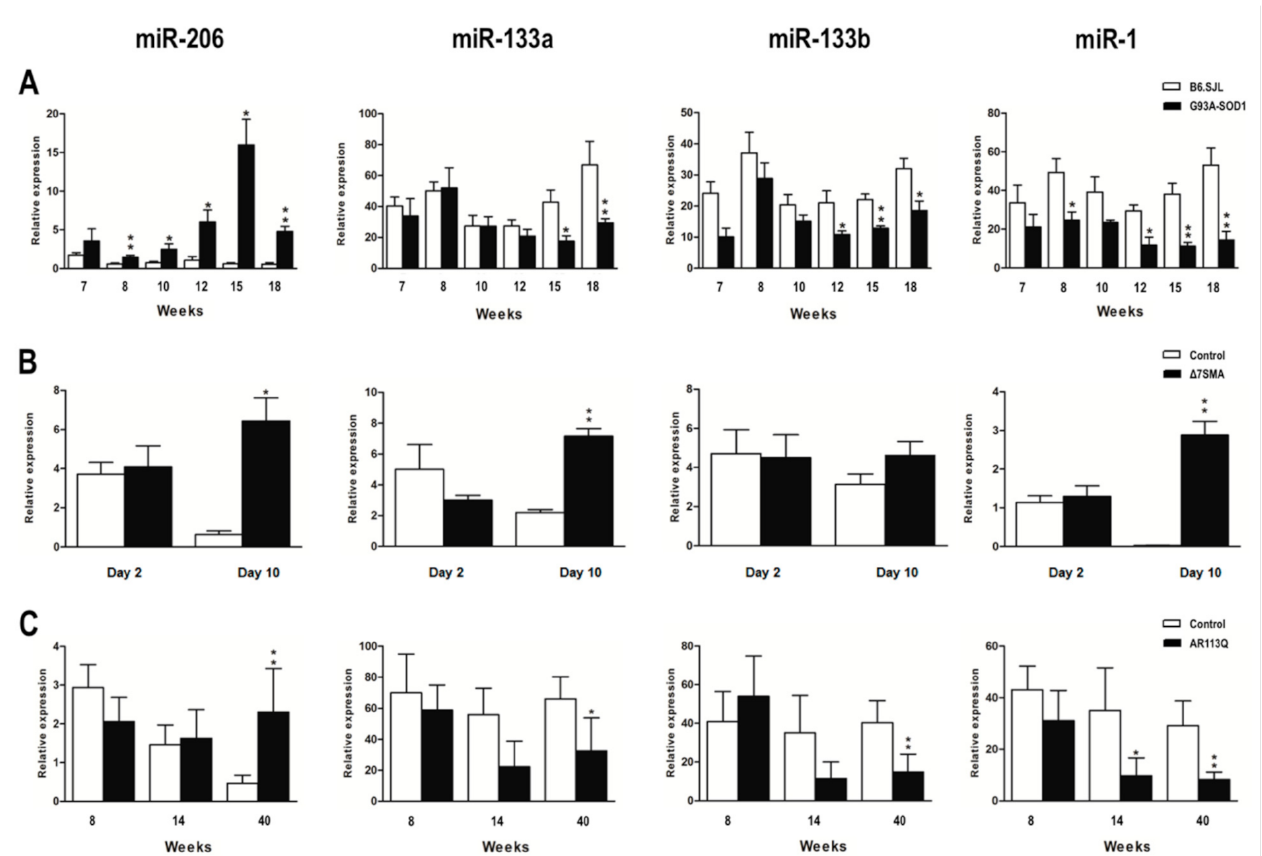
Figure 1. Altered expression of myomiRs in G93A-SOD1, ∆ 7SMA, and AR113Q mouse muscle tissue as disease progresses. Quantitative real-time PCR analysis of myomiRs in total RNA extracted from gastrocnemius muscle tissue of ( A ) G93A- SOD1 (black bars), ( B ) ∆ 7SMA (black bars), and ( C ) AR113Q (black bars) and control mice (white bars) at different stages of disease (5 mice per group). Relative expression data are presented as mean ± SEM of 2 − ∆ Ct values normalized against endogenous control U6. * p < 0.05, ** p < 0.01, Mann–Whitney